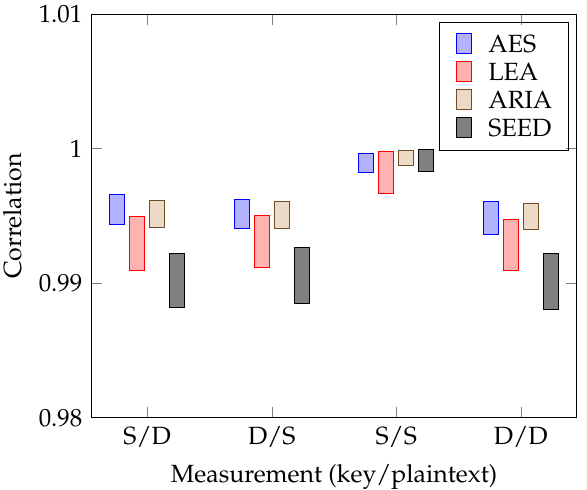
Figure 4. Correlation coefficient between power consumption traces, S/D, D/S, S/S, and D/D represent same key/different plaintext, different key/same plaintext, same key/same plaintext, and different key/different plaintext,